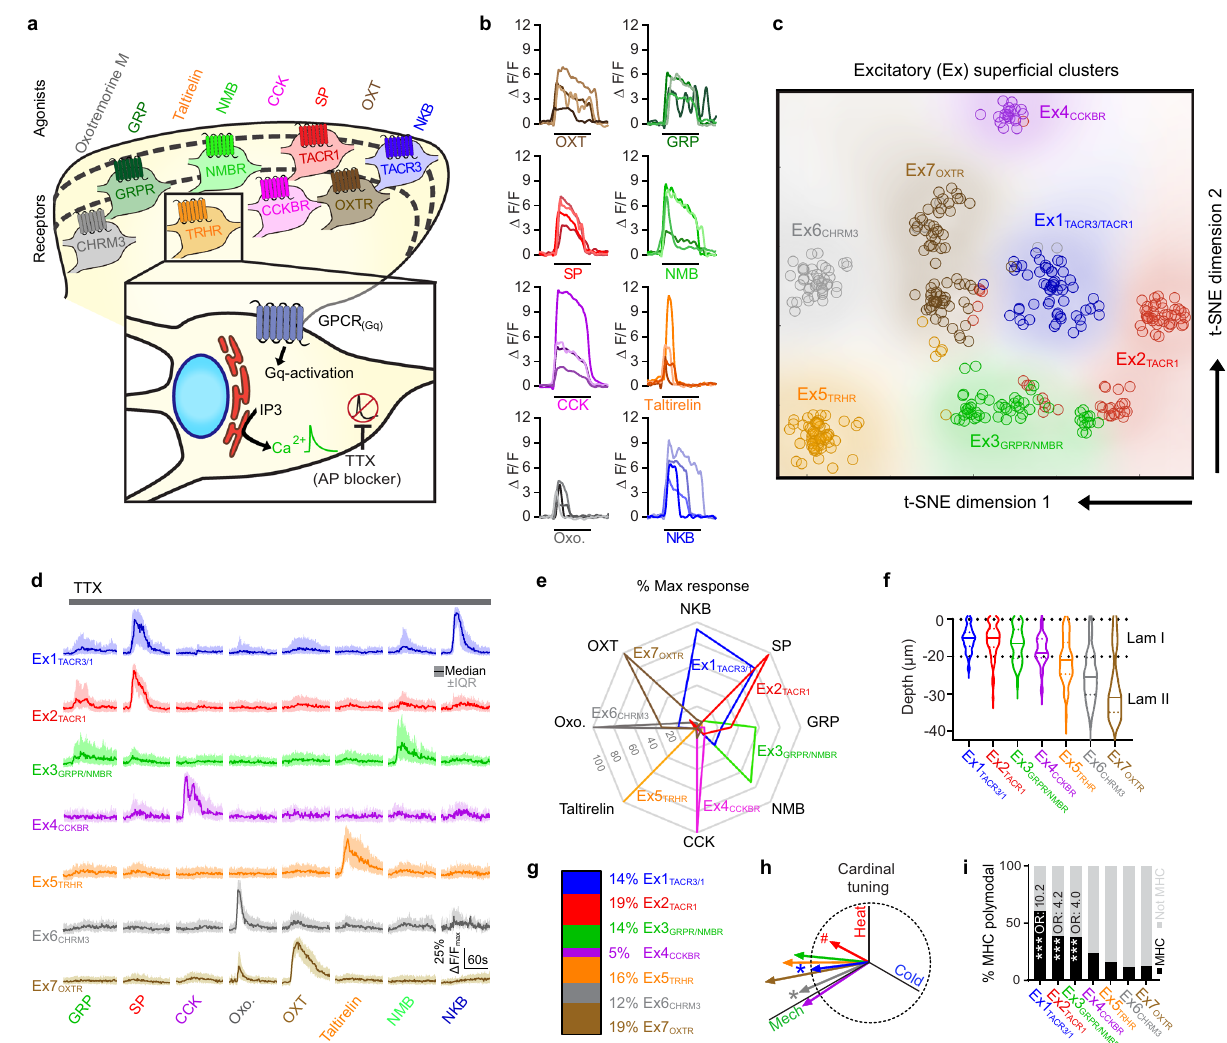
Fig. 4 | CICADA: Cell-type identi fi cation by Ca 2+ coupled activity through drug activity.a OverviewofCICADAshowingtheintracellularmechanisms (inset)and the agonists used to target the speci fi ed receptors (top). b Representative Δ F/F Ca 2+ traces for each of the CICADA ligands. Each trace is a different cell. SP, 1 µ M; OXT, 1 µ M; GRP, 300nM; Oxotremorine M (Oxo.) 50 µ M; Taltirelin, 3 µ M; NMB, 100nM;CCK,200nM;NKB,500nM. c t-SNEplotofexcitatorysuper fi cialclusters (Ex) identi fi ed by CICADA. Each dot represents a CICADA-identi fi ed cell, color- coded for the appropriate cluster with the cluster regions color coded by shad- ing. Cluster numbers ( e.g . Ex2) are followed by the principal receptor found in that population of cells (Ex2 TACR1 ). d Normalized Ca 2+ traces of each CICADA ligand for Ex1-7. Each cell ’ s Δ F/F trace was normalized to a maximum of 1 and minimum of 0. Data are shown as median±interquartile range. Ex1 TACR3/1 , 57 cells;Ex2 TACR1 ,75cells;Ex3 GRPR/NMBR ,57cells;Ex4 CCKBR ,21cells;Ex5 TRHR ,65cells; Ex6 CHRM3 , 49 cells; Ex7 OXTR , 74 cells (cells are pooled from 4 mice). e Radar chart showing the response to CICADA ligands within each population. The spoke